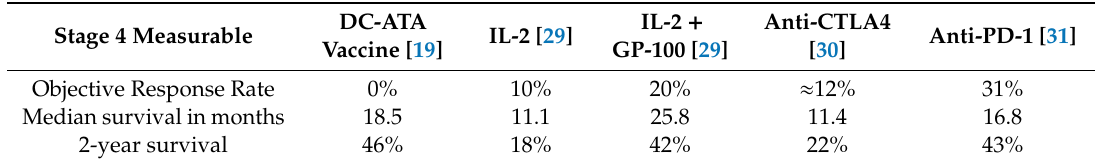
Table 4. Survival and response rates associated with immunotherapies in patients with measurable stage 4 metastatic melanoma at the time of